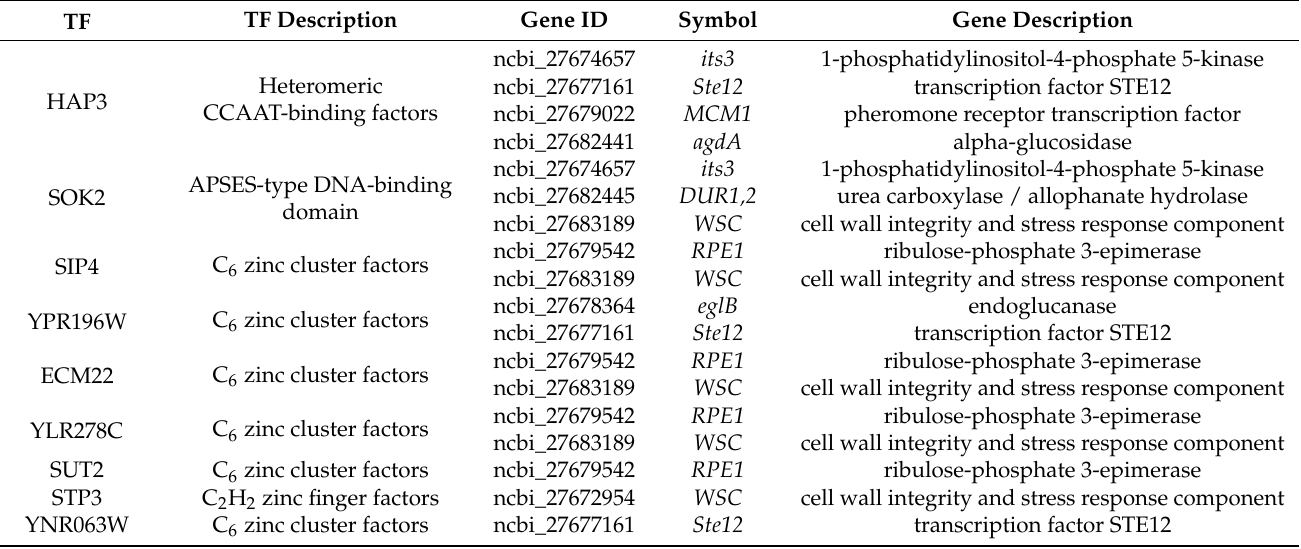
Table 2. The information on the transcription factors regulating